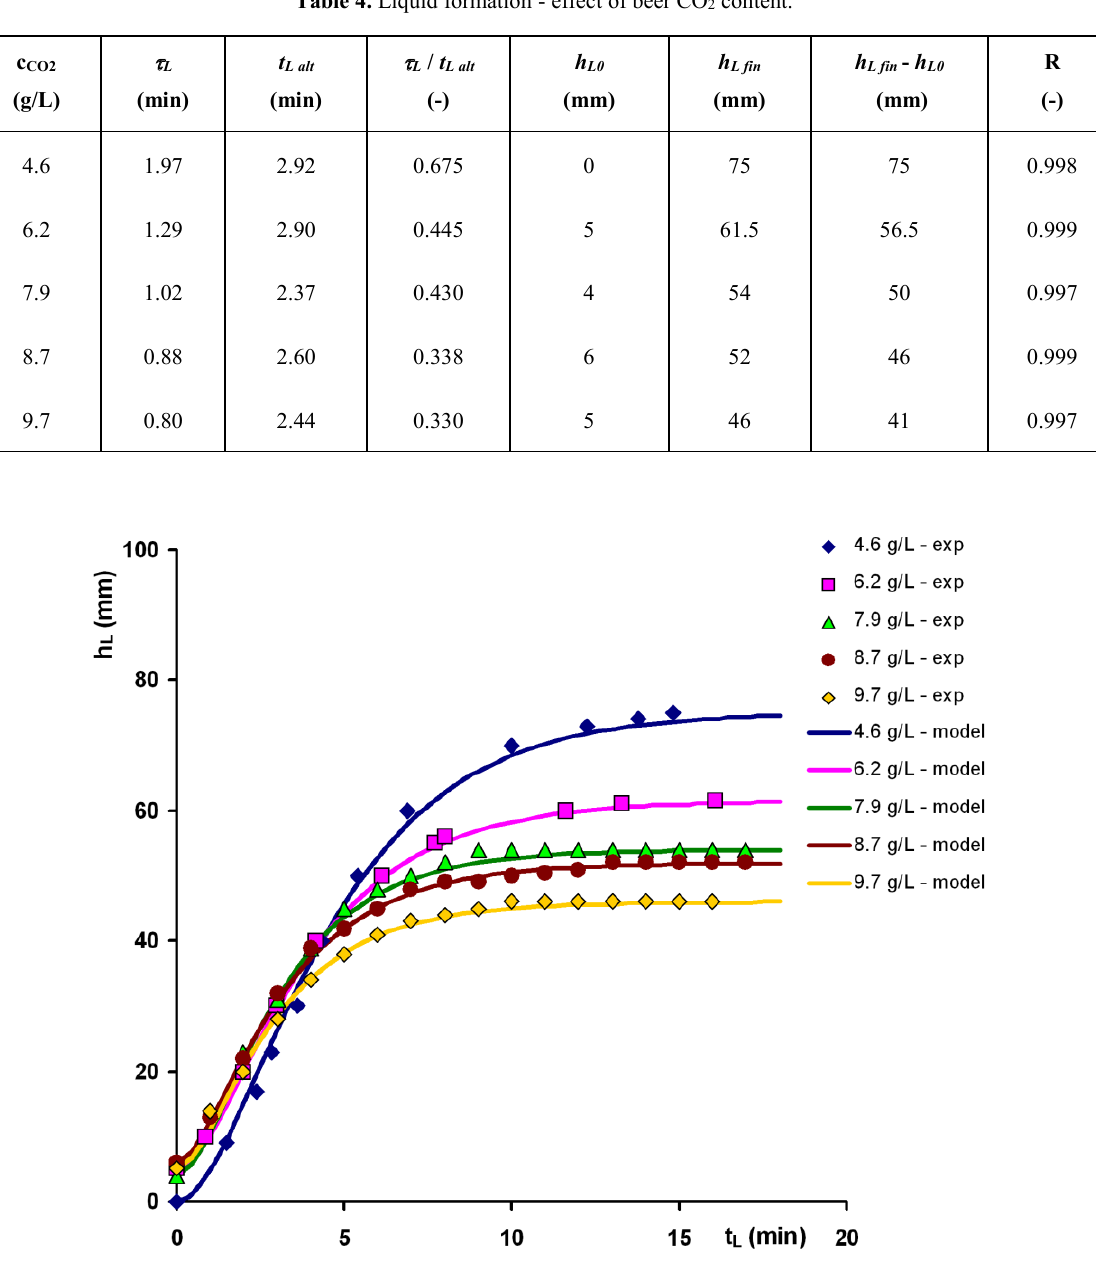
Table 4. Liquid formation - effect of beer CO 2 content.